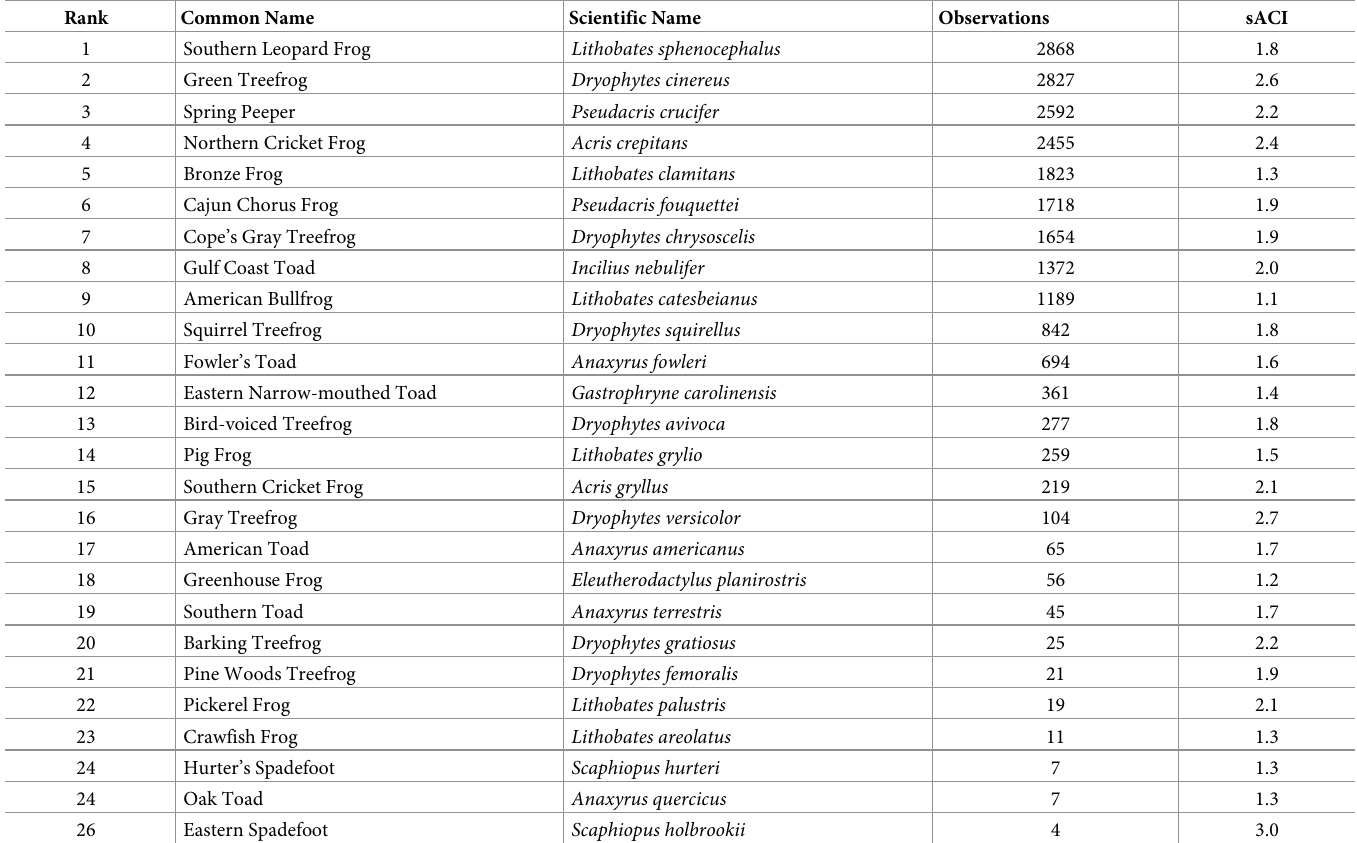
Table 3. List of species